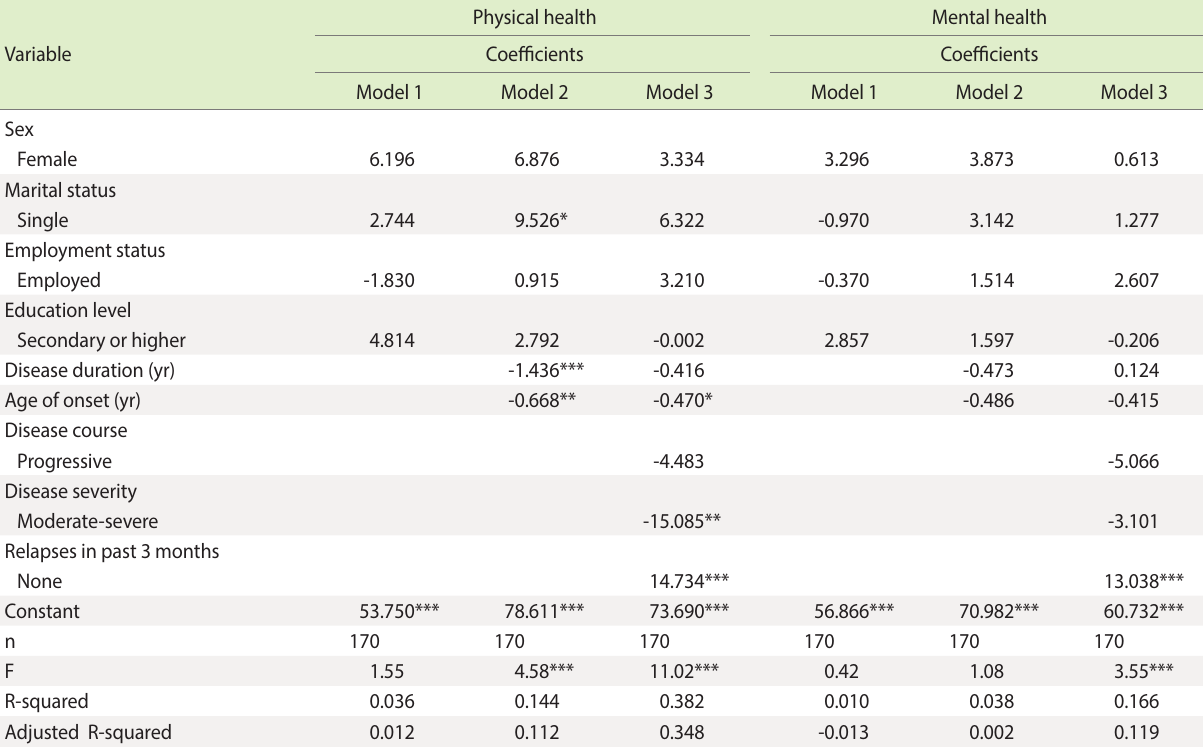
Table 4. Results of hierarchical regression assessing the effects of demographic and clinical variables on physical- and mental health